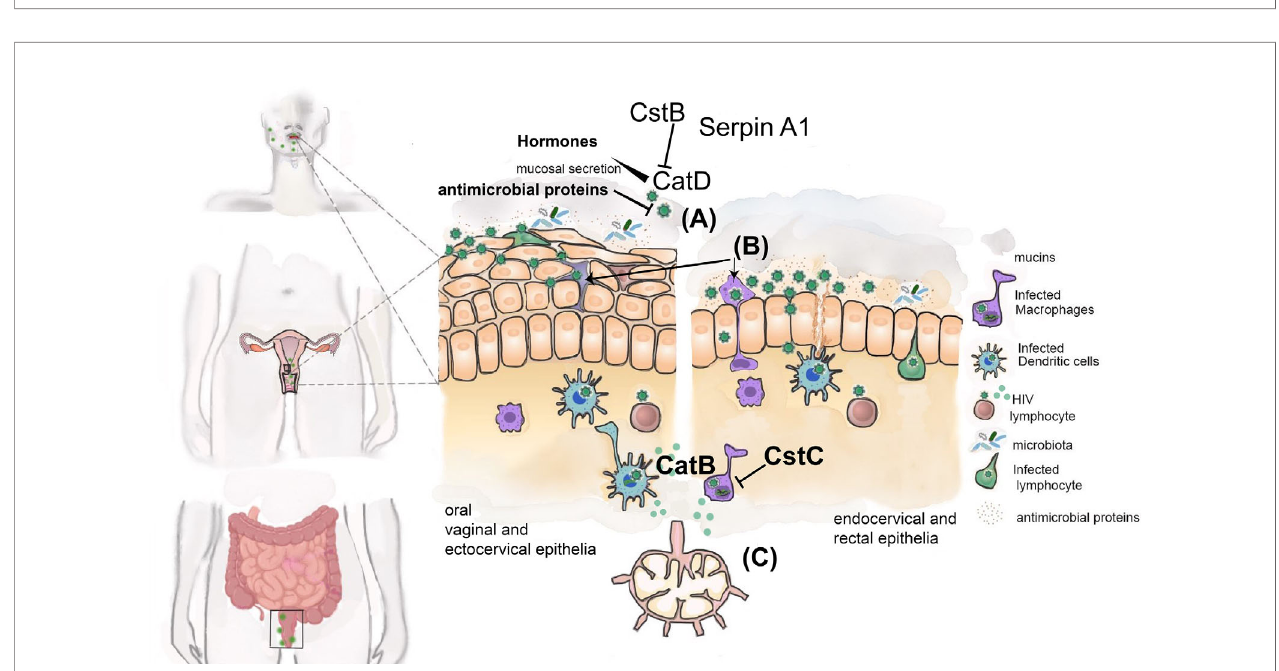
FIGURE 1 | Cathepsins and their endogenous inhibitors during TB infection and HIV-co-infection. (A) Mtb has to overcome the strong mucosae in fl ammatory environment of the upper and lower respiratory tract where cathepsins B, L and S may have a direct killing effect. In in fl ammatory conditions their exacerbated secretion may contribute to cleavage of other antimicrobial proteins helping pathogen protection and transmission. (B) In the alveolar environment Mtb internalized by alveolar macrophages downregulates cathepsins contributing for establishment of intracellular niches. (C) Infected cells will move to the deeper lung tissue forming an innate granuloma. (D) Adaptive immune granuloma is a dynamic structure of apoptosis of infected macrophages induced by cytosolic cathepsins (as cathepsin B) releasing live bacilli in apoptotic bodies that are readily internalized by new arrival macrophages. (E) During active TB, the exacerbated secretion of cathepsins G, K, D, S and B in the granuloma and from cells in the lung tissue stimulated by Mtb products leads to collagen destruction, cavitation and, bacteria spread to other humans. (F) HIV arrival to the lung in latently infected macrophages, under an in fl ammatory environment of cytokines will start to replicate. Cathepsin B by processing viral proteins will participate in the formation of new viral particles. Csts B and C will inhibit this process. Co-infection with HIV leading to lymphocyte depletion, death of monocytes at the site of virus replication and low secretion of TNF compromises the dynamics of granuloma, their integrity, culminating with infected cells spread to other parts of the body.